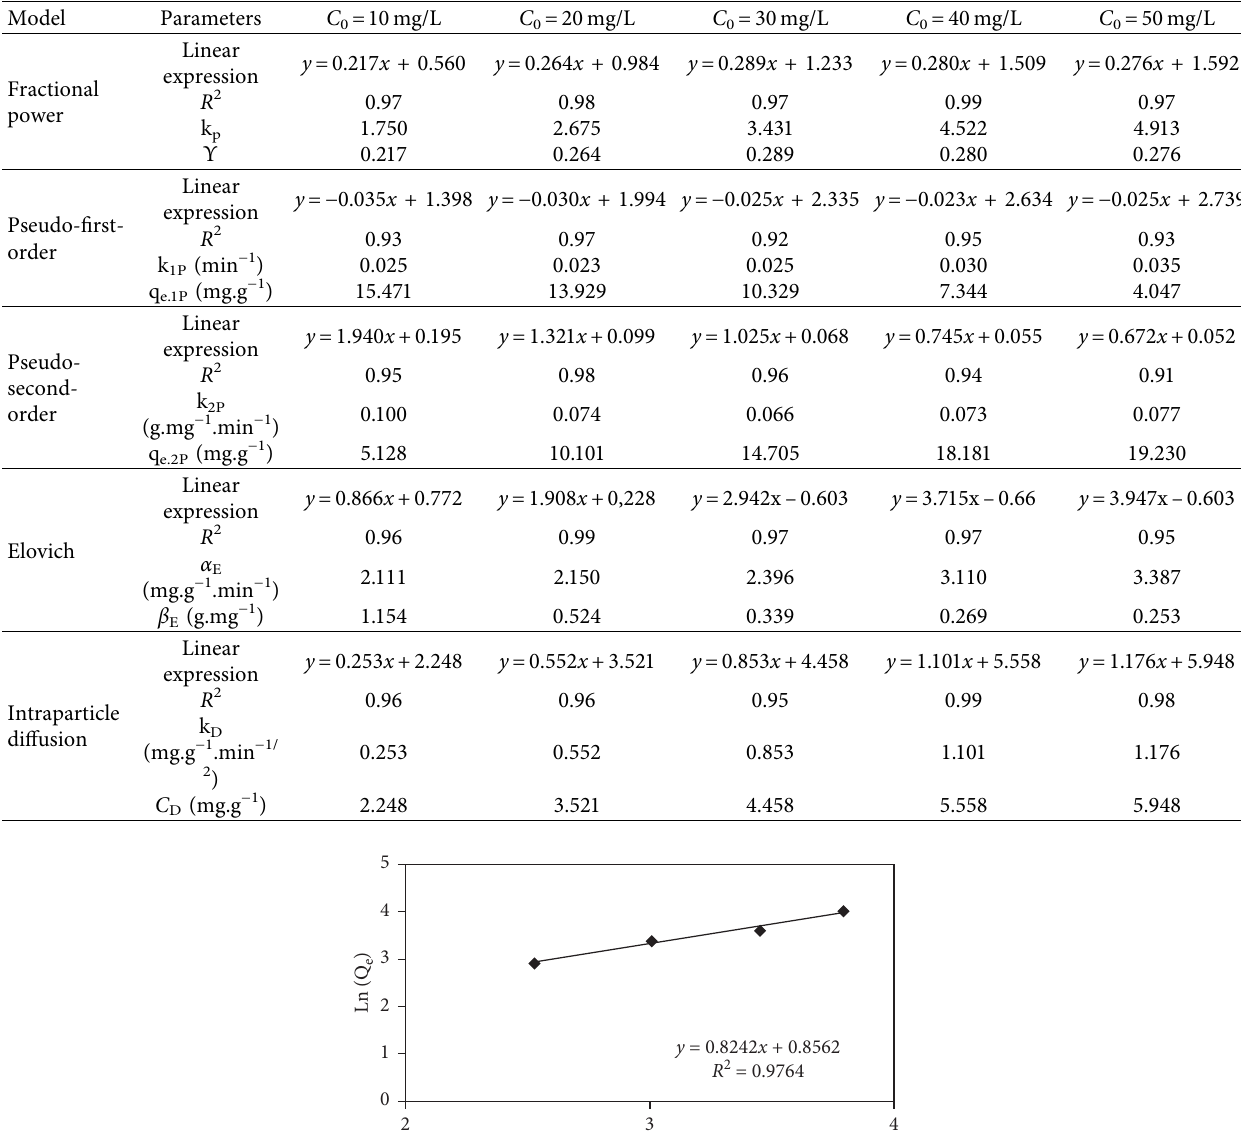
Figure 14: Linearity of intraparticle diffusion model. Table 2: Adsorption kinetic model parameters at pH 2 for Cr(VI) removal.